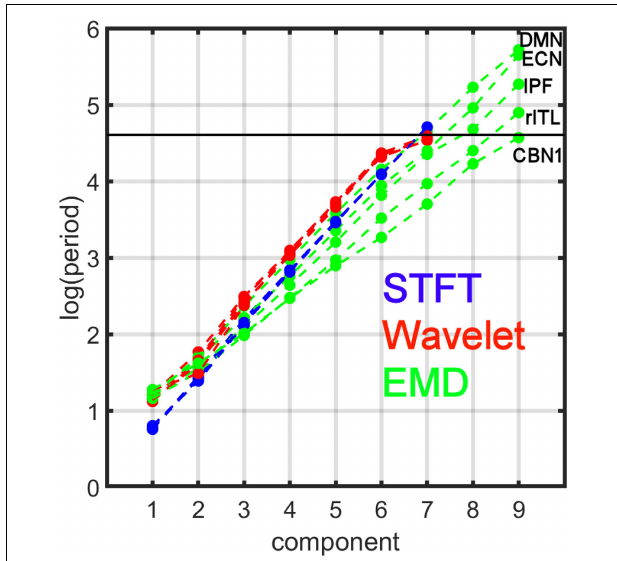
FIGURE 7 | Comparison of period profiles averaged over all subjects using Short-Time Fourier Transform (STFT), Maximal Overlap Discrete Wavelet Transform (MODWT), and Empirical Mode Decomposition (EMD) for the different resting-state networks from Figure 5 . Different resting-state networks show deviations to a perfect dyadic decomposition for EMD. Low-frequency networks (for example DMN) show the least deviation of EMD with STFT and MODWT, whereas high-frequency networks (for example CBN1) show largest deviations (similar to Figure 3 ). Note that these 5 networks were chosen to be representative networks of the clusters 1 to 5 in Figure 10 . See also corresponding Tables 1 , 2 .